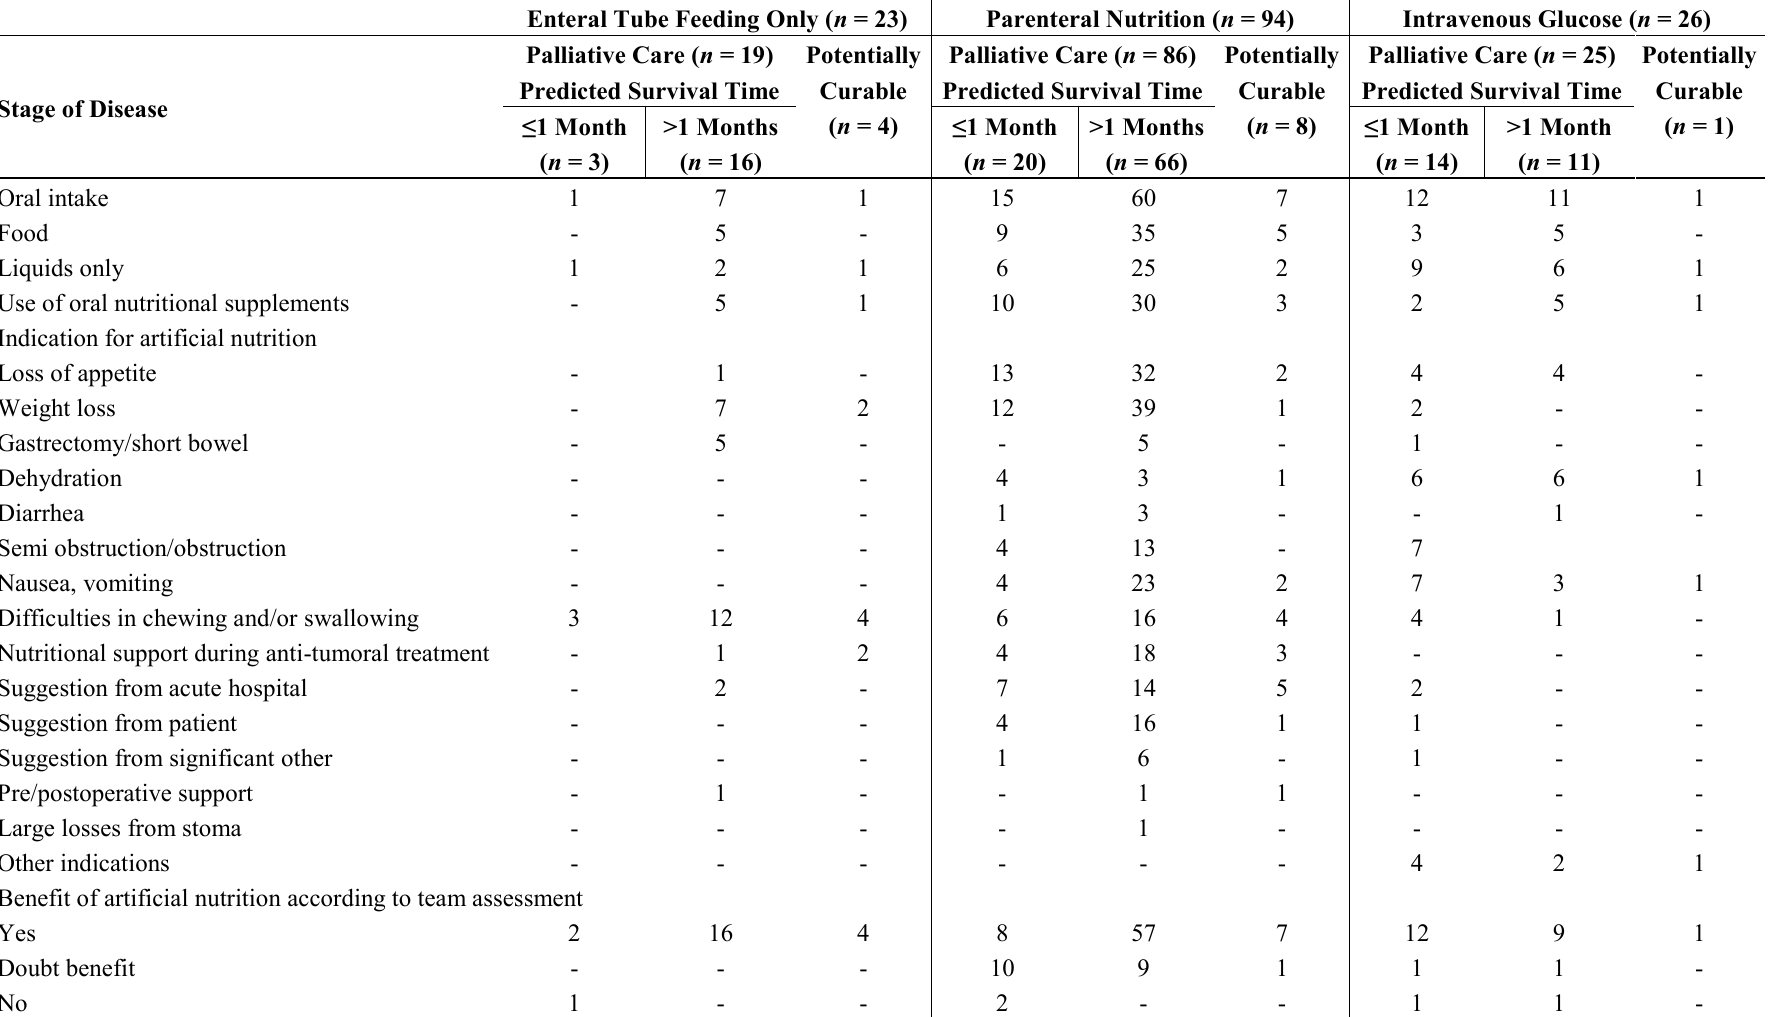
Table 2. Oral intake, indication * and evaluation of patients receiving enteral tube feeding, parenteral nutrition and intravenous glucose in relation to expected